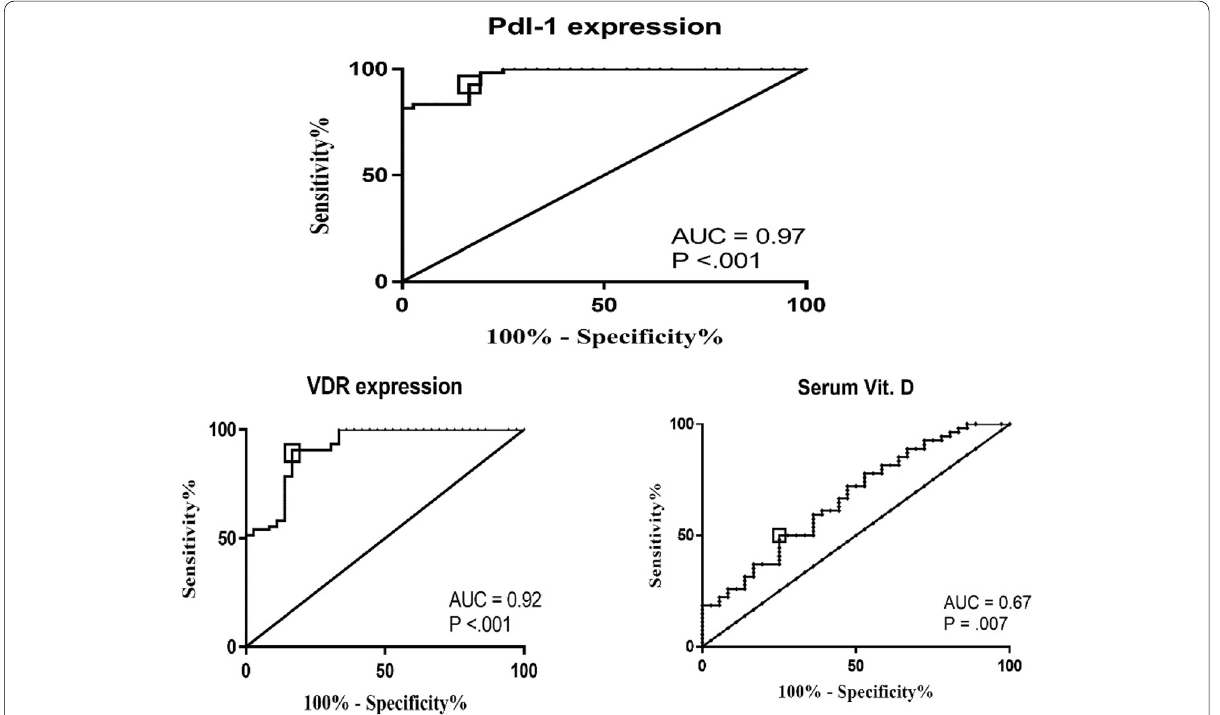
Fig. 3 ROC curve for PDL‑1, VDR expressions and serum vitamin D in cases. (ROC Curve analysis was done by Prism